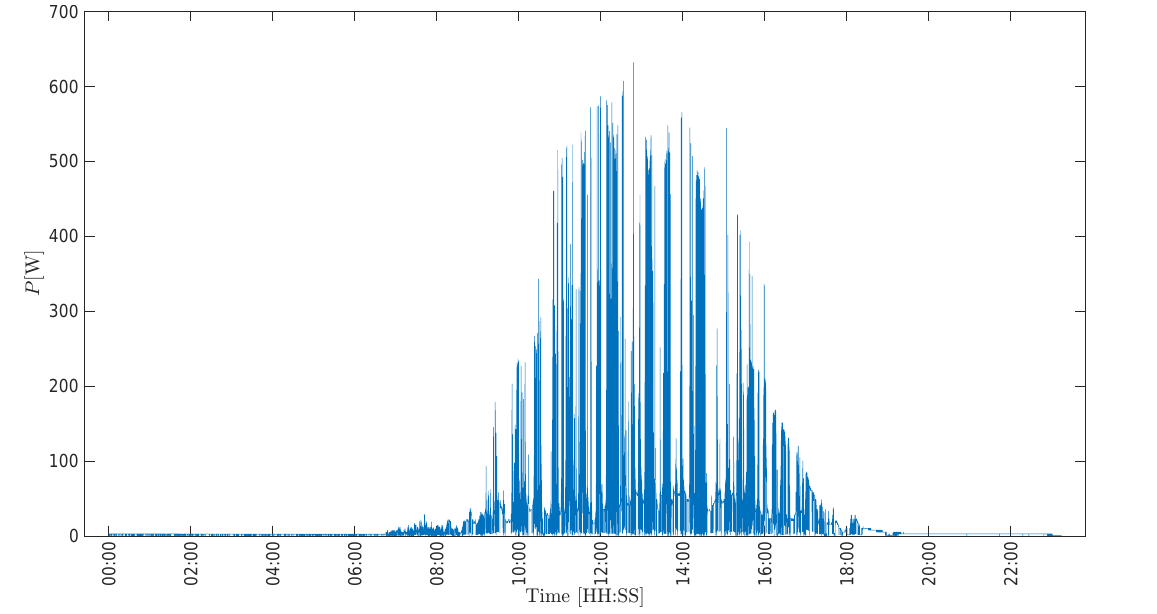
Figure 9. Sample data from a photovoltaic installation.